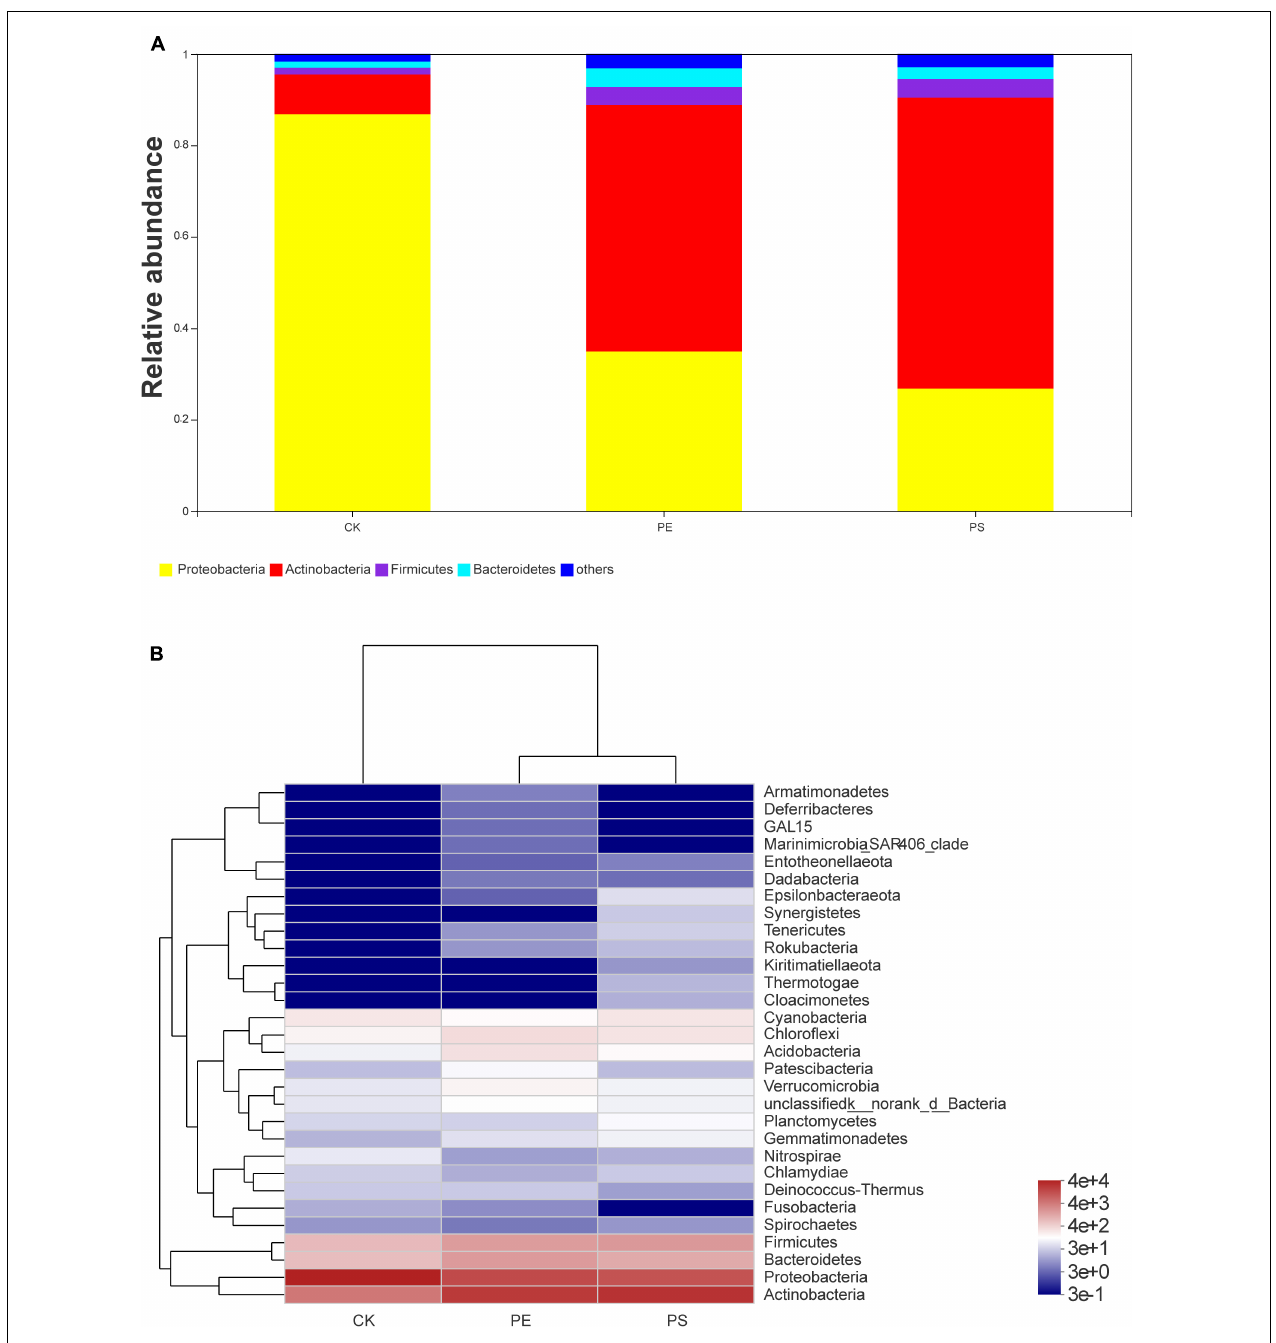
FIGURE 9 | Relative abundance of intestinal microbiota at the phylum level: (A) bar plot and (B) heat map